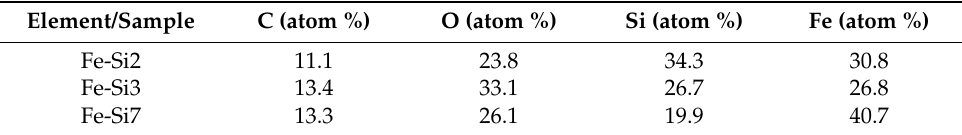
Figure 2. Superposed X-ray diffractograms for the Fe-Si2, Fe-Si3, and Fe-Si7 raw nanopowders, and the reference diffractograms for Fe-based phases. Table 2. Elemental composition of powders extracted from EDX analyses.